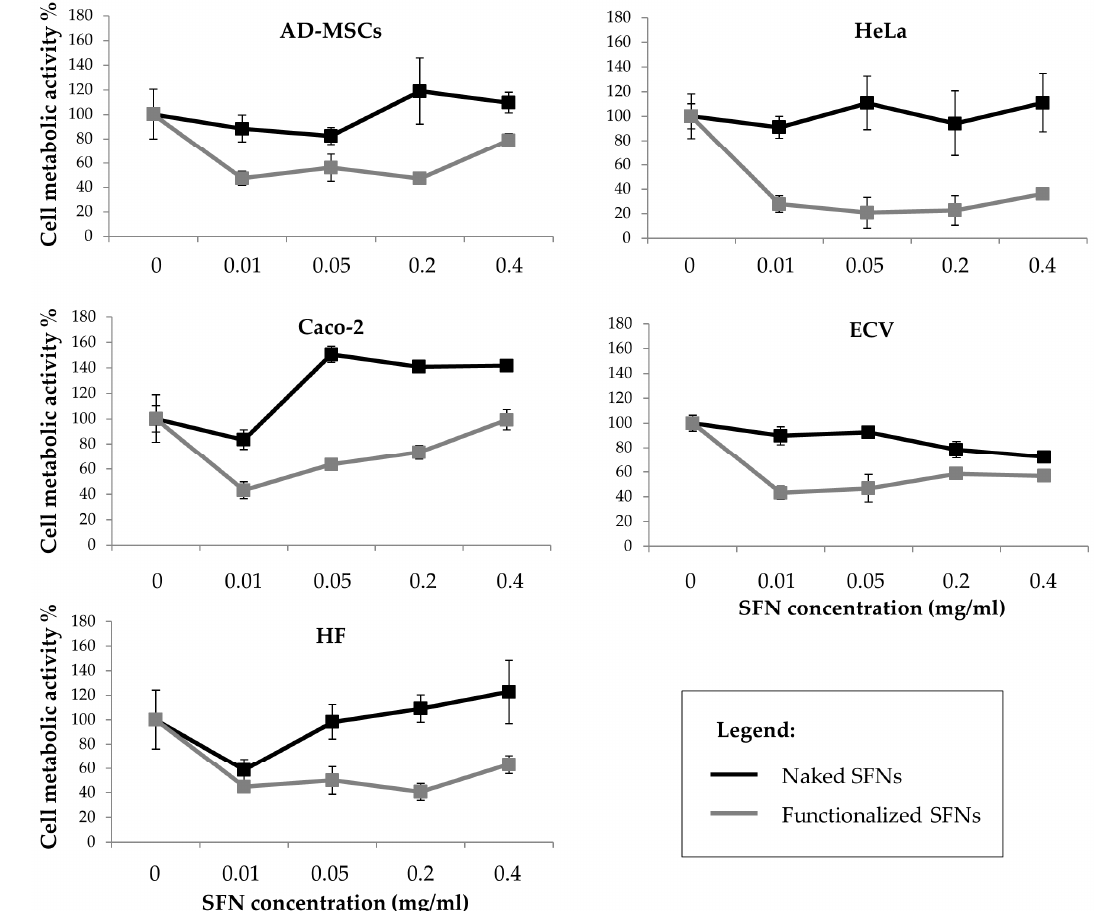
Figure 5. Cell metabolic activity of all considered cell lines treated with increasing doses of curcumin-loaded naked (black line) and functionalized (grey line) SFNs. Data are reported as mean values and least significant difference (LSD) intervals, ANOVA. The overlap of two LSD intervals graphically indicates the absence of significant differences ( p > 0.05).